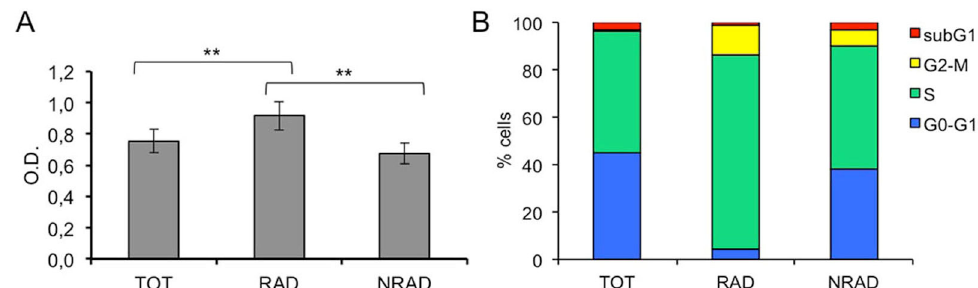
Figure 2. Proliferative ability of cSCCs subpopulations in vitro . ( A ) RAD, NRAD and TOT cells ability to proliferate in vitro was evaluated by CV staining; ( B ) RAD, NRAD and TOT cells were cultured for 72 h. BrdU incorporation was then evaluated by using FITC BrdU Flow Kit and analyzed by flow cytometry 72 h after the seeding. ** p < 0.01; ( C ) Monoparametric histograms showing BrdU incorporation by FACS; ( D ) Density dot plots showing BrdU incorporation by